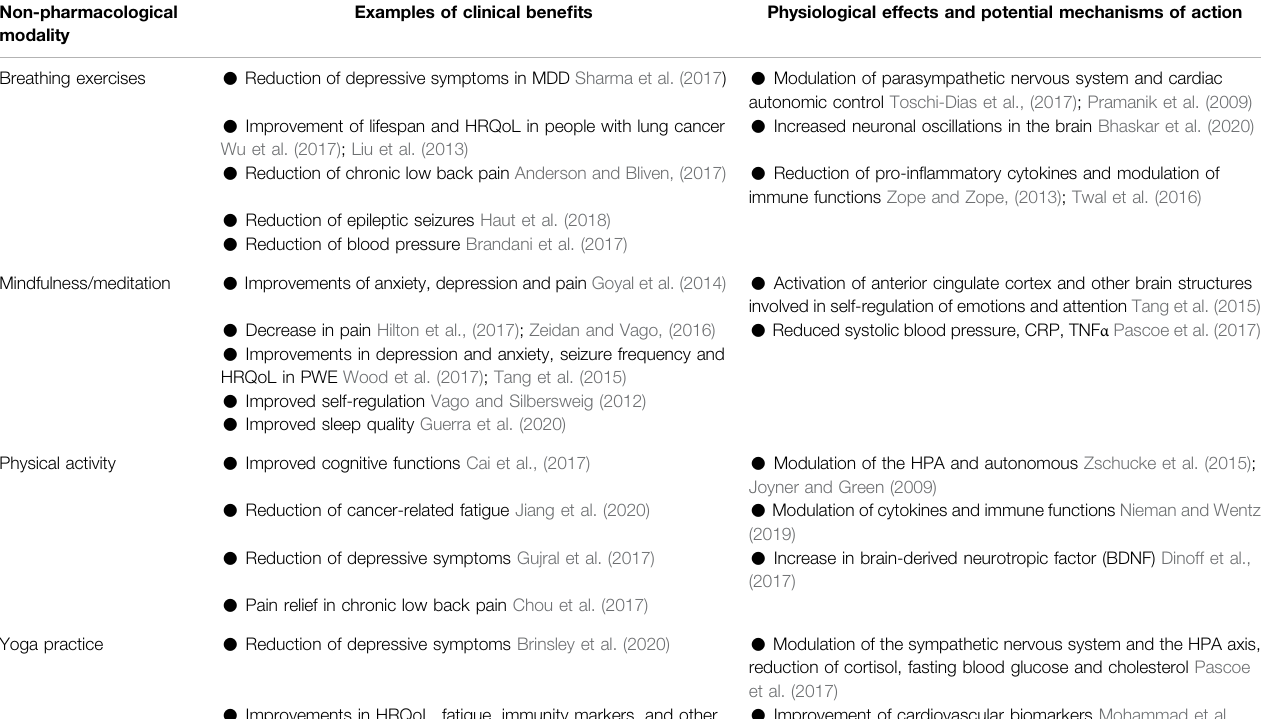
TABLE 1 | Examples of clinically-bene fi cial self-care modalities and their physiological effects. Non-pharmacological Examples of clinical bene fi ts Physiological effects and potential mechanisms of modality